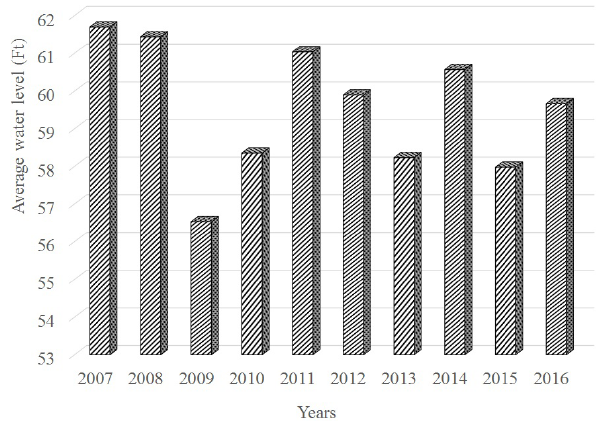
Figure 2. Water Supply of Oyan dam between 2010 and 2016. Figure 3. Average Yearly Water Level of Oyan dam Source: OORBDA,